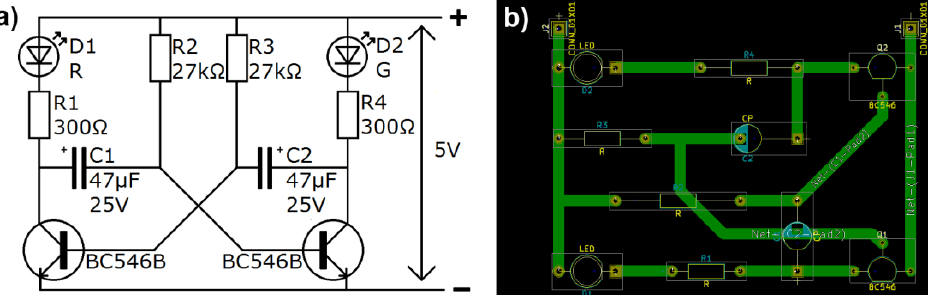
Figure 6. ( a ) Electrical diagram of the symmetrical, astable multivibrator; ( b ) printed circuit board layout.